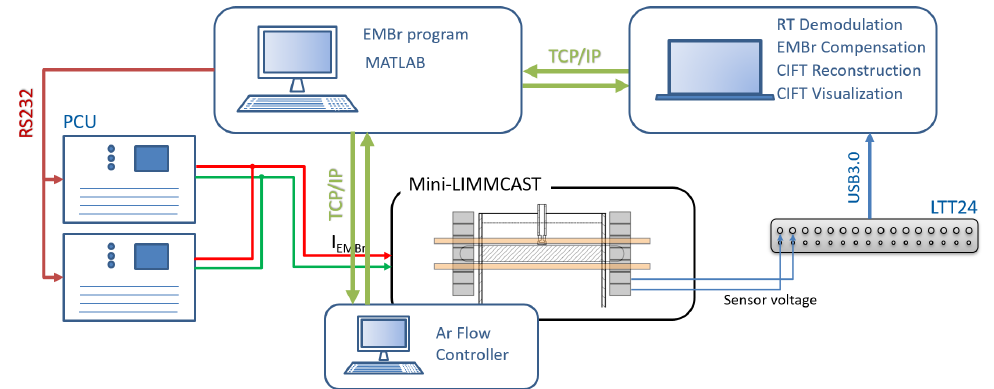
Figure A2. Communication network diagram showing the communication protocols between system